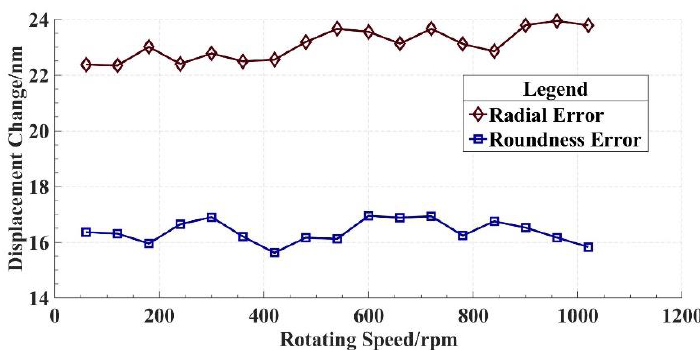
Figure 16. Line graph of measurement results.